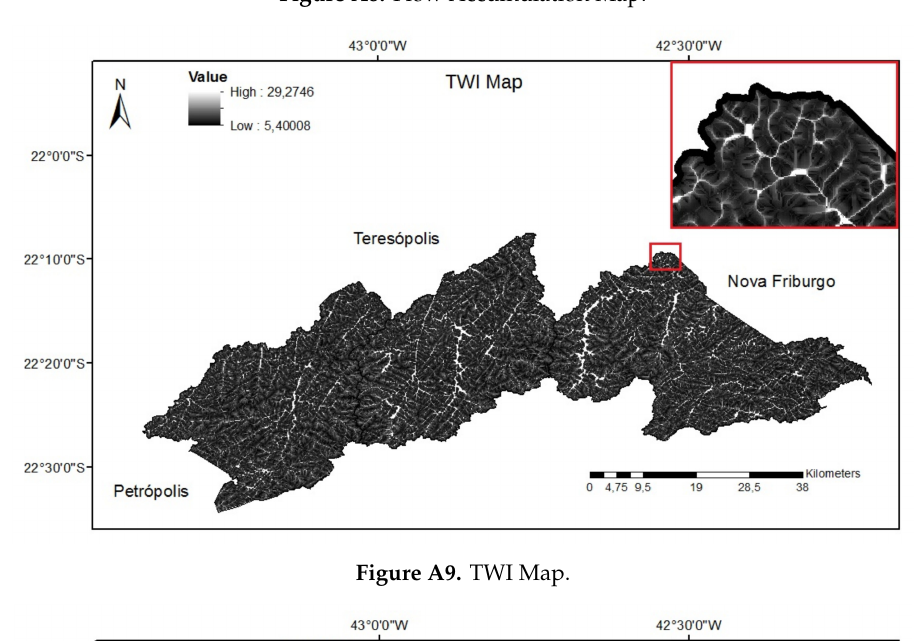
Figure A9. TWI Map.